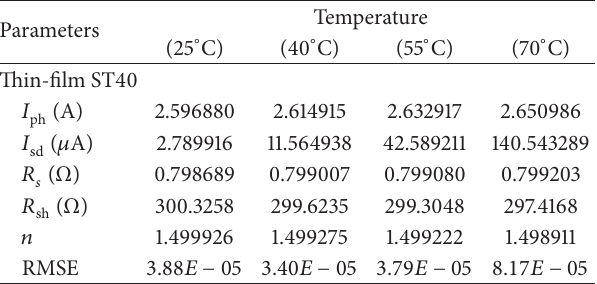
Table 14: The extracted parameters for thin-film ST40 PV module by PCE at different temperatures and values of irradiance of 1000 W/m 2 .